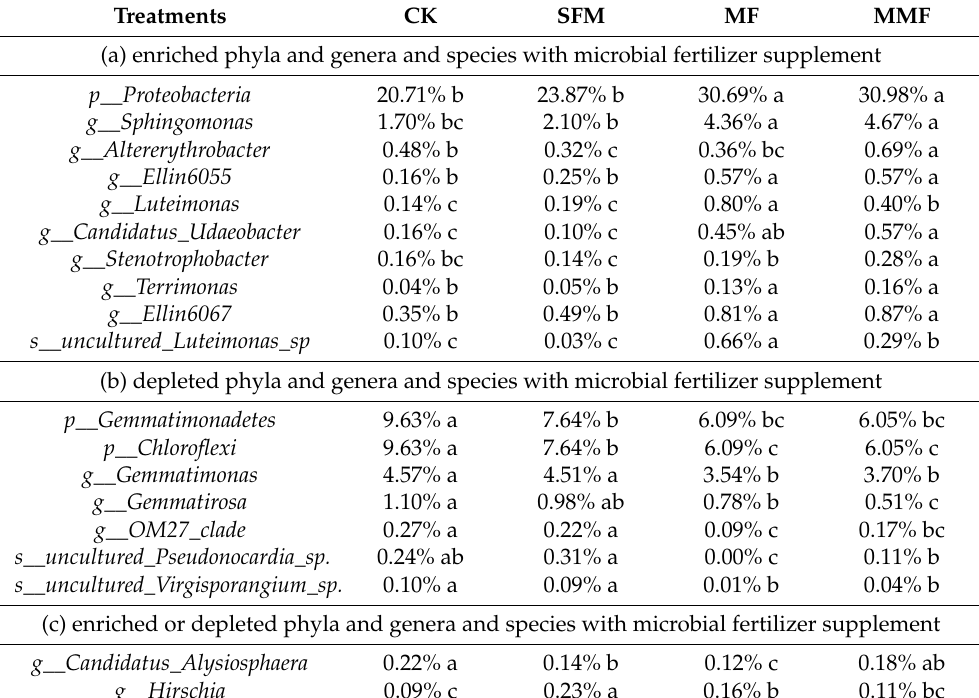
Table 3. The bacterial group significantly changed ( p < 0.05) total reads of Lanzhou lily rhizosphere soil from Illumina NovaSeq data (the phyla with average RA > 5%, and the genera with average relative abundance > 0.1% and the species with average relative abundance > 0.05%; the accession number is ID PRJNA805390): the significance is 0.05 for lower letters (a, b, c) presented in